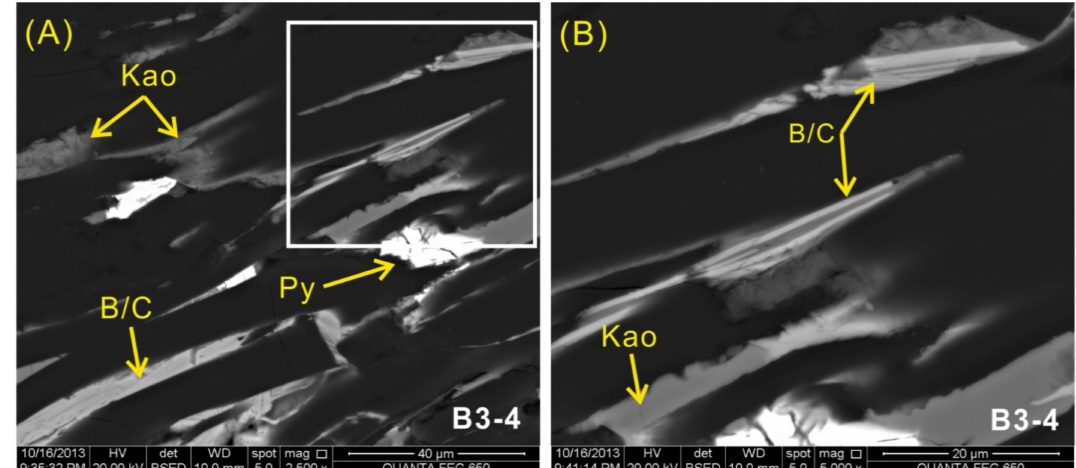
Figure 6. SEM back-scattered electron images of clay minerals in coal sample B3-4. ( A ) Cell-filling interstratified berthier- ine/chamosite, kaolinite, and pyrite. ( B ) Enlargement of rectangle in ( A ). B/C: interstratified berthierine/chamosite. Kao: kaolinite. Py: pyrite.